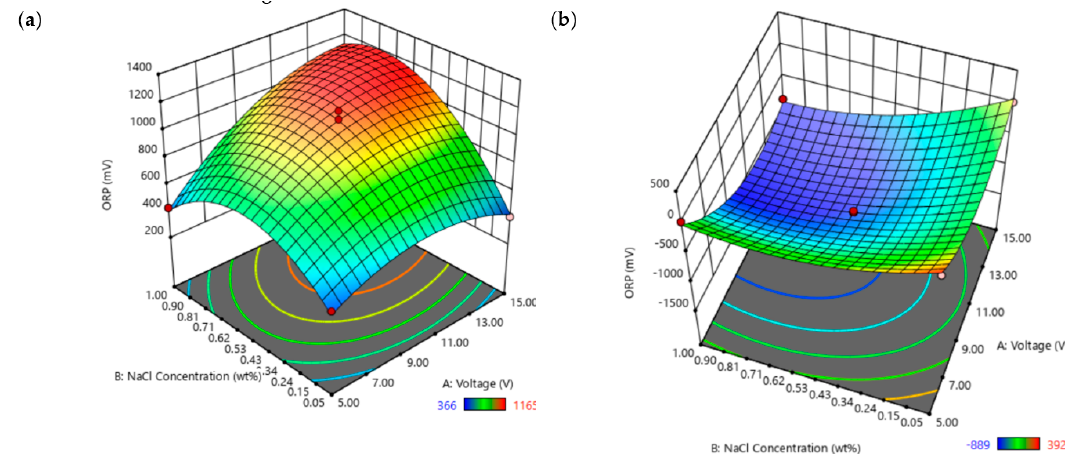
Figure 2. Response surface plot of the pH of: ( a ) AcEW and ( b ) AlEW due to the combined effect of the NaCl concentration and the voltage.